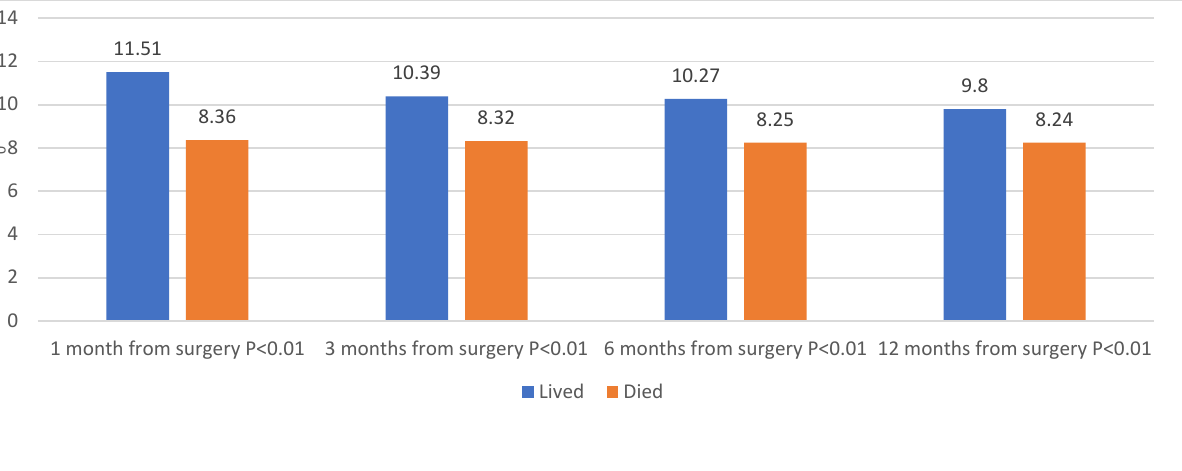
Figure 2. Primary outcome (all-cause mortality) as a function of NLR. All-cause mortality during the first year following a proximal femur fracture surgery in 1551 elderly patients (altogether: 1278 (82.4%) lived, 273 (17.6%) died). NLR 0 : neutrophile/Lymphocyte ratio.